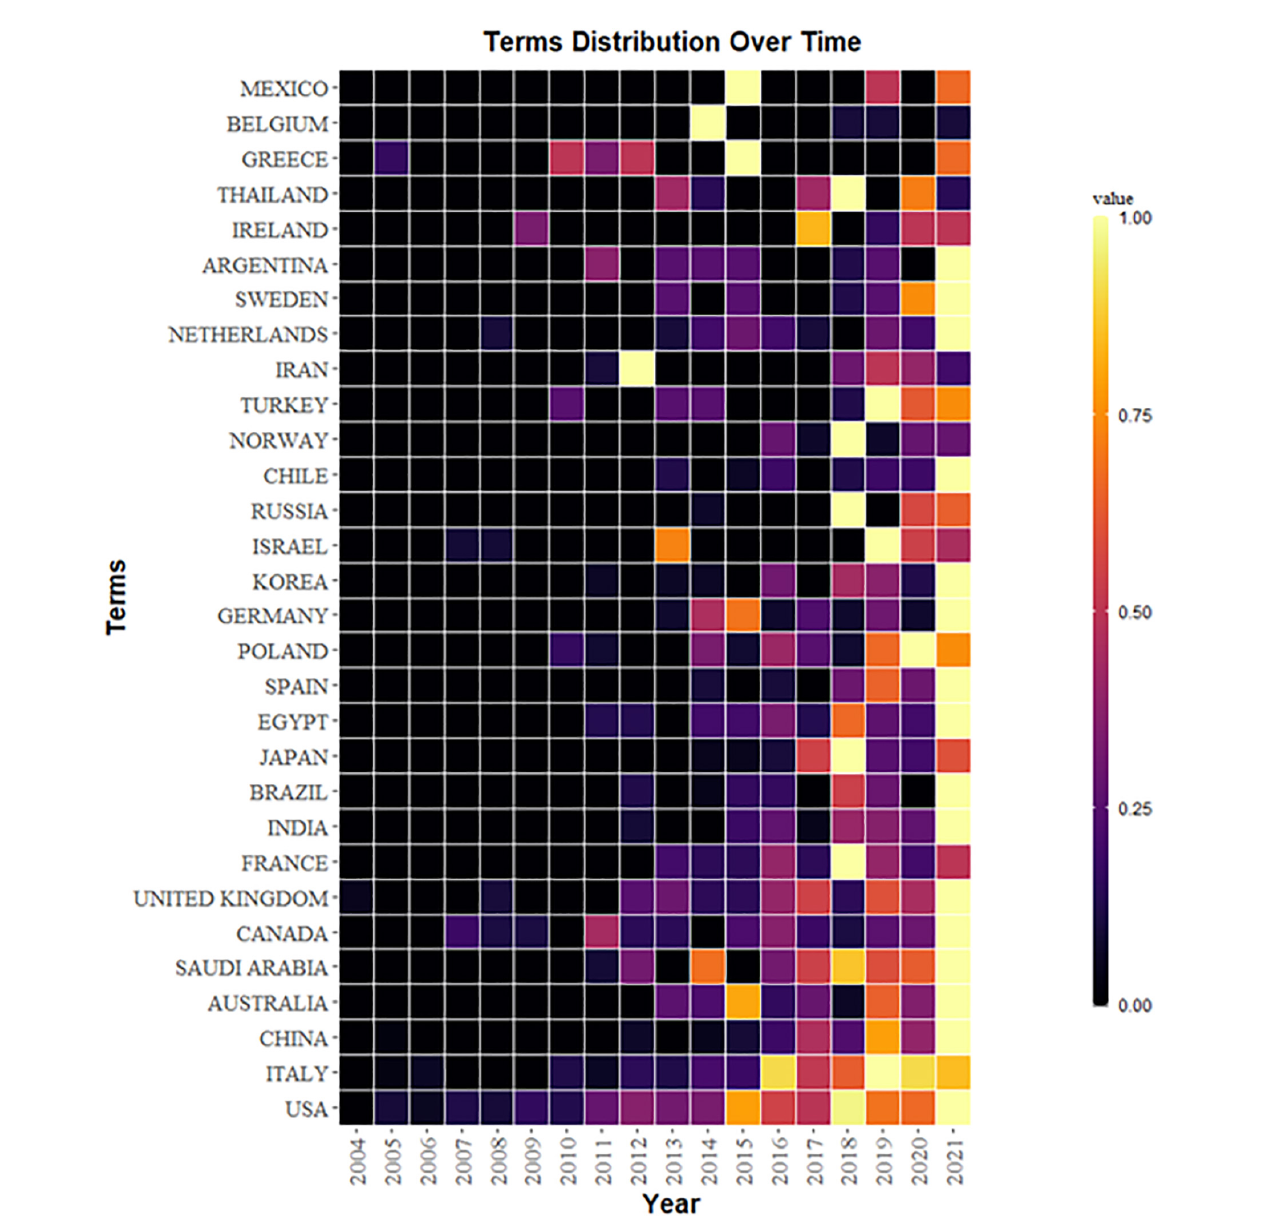
FIGURE2 Heat map of country distribution over time: The closer the color is to yellow, the closer the value is to 1, which represents the larger number of publications in the